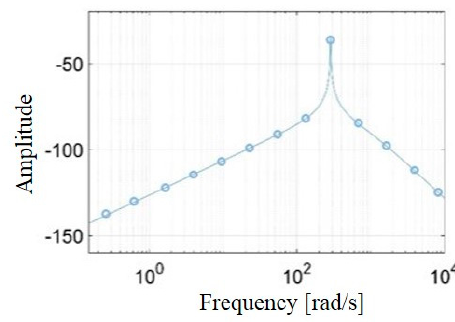
Figure 6. Transfer function shape of the resonant circuit using the INS coil.